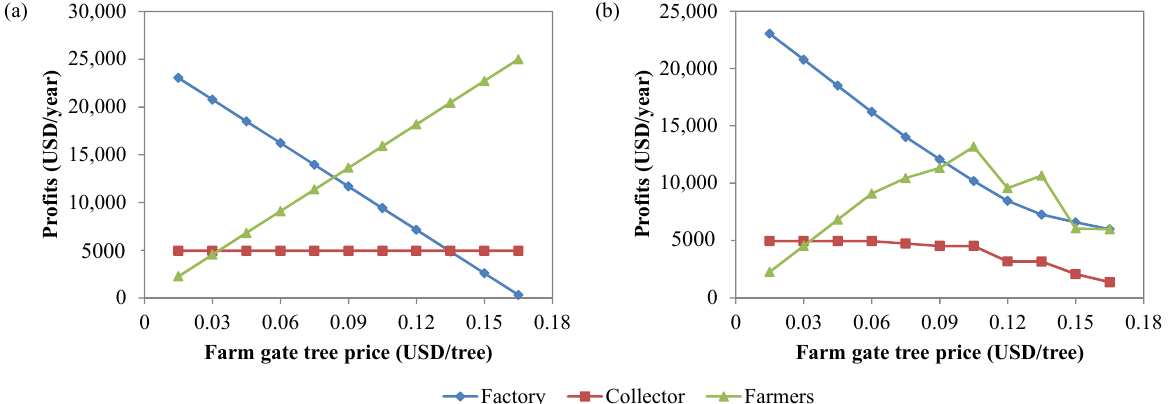
Figure 3. Profits obtained for each stakeholder from ( a ) scenario T1 and ( b ) scenario T2. Figure 3. Pro fi ts obtained for each stakeholder from ( a ) scenario T1 and ( b ) scenario T2.